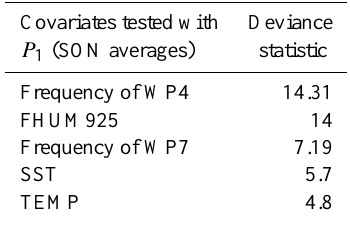
Table 1. Deviance statistic for the covariates tested with the Poisson distribution.